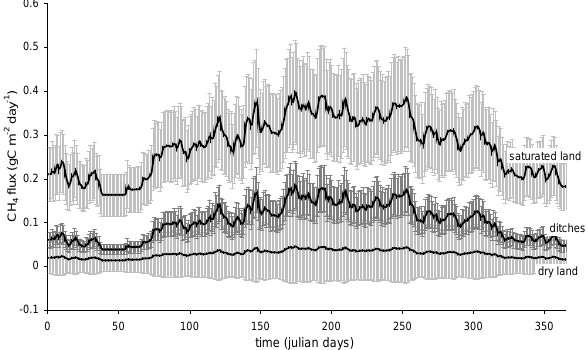
Figure 8: Modelled daily CH 4 fluxes for relatively dry land, saturated land and ditches over 2005. Error-bars indicate the variance error from the regression analysis.